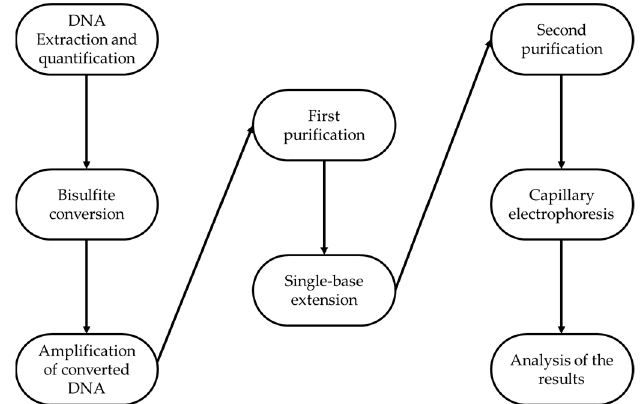
Figure 2. Experimental work fl ow.